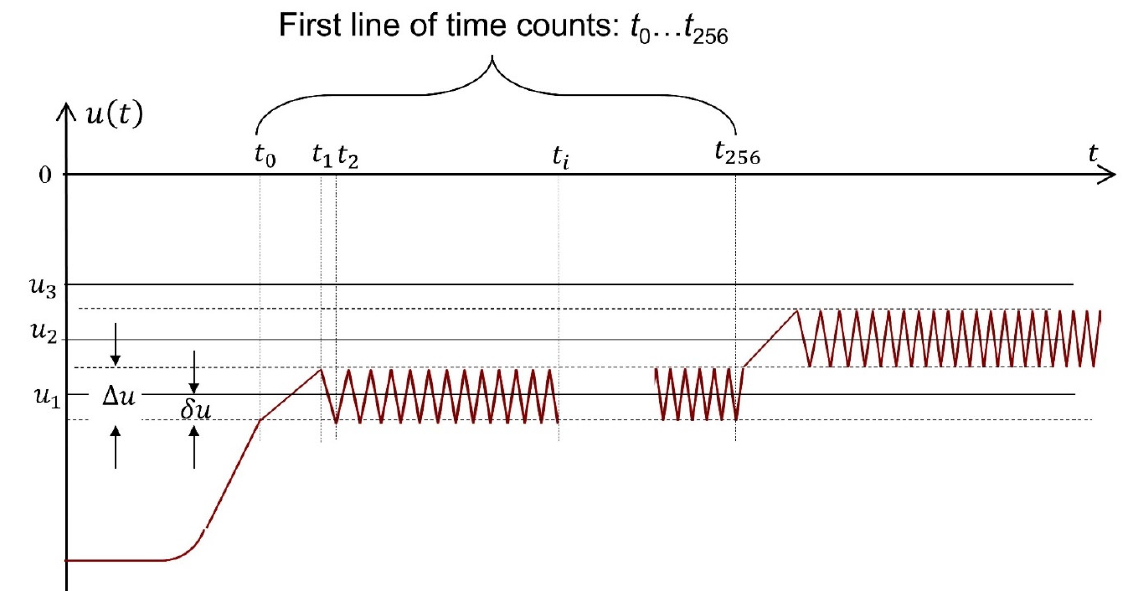
Figure 3. The change of the working electrode potential during time intervals is shown schemati-